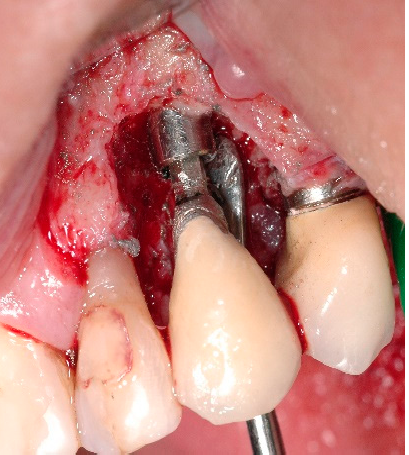
Figure 3. Clinical image after debriding, showing significant bone loss before treatment.